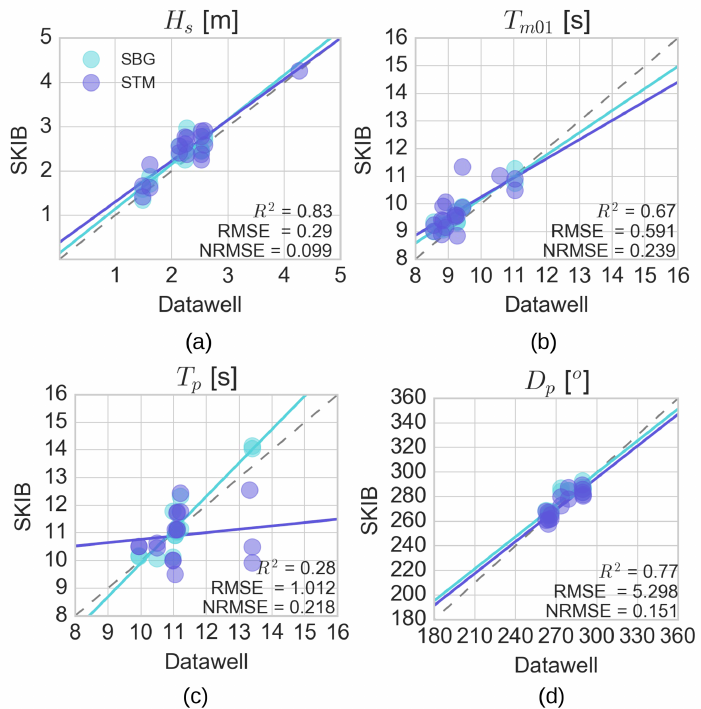
Figure 4. Comparison of the integrated wave parameter estimates from Datawell and SKIB with SBG (IMU sensor) and STM (accelerome- ter). (a) Significant wave height ( H s ). (b) Mean wave period ( T m01 ). (c) Peak wave period ( T p ) and (d) peak direction ( D p ) for a frequency interval between 0.06 and 0.6Hz. The regression lines are computed independently for the SBG and STM data set. The gray dashed line represent the ideal correlation regression line, and the statistics coefficients written in the figures are computed considering both data sets from SBG and STM. The statistical parameters are the Pearson’s coefficient of determination R 2 , the root mean square error (RMSE) and the normalized root mean square error (NRMSE).